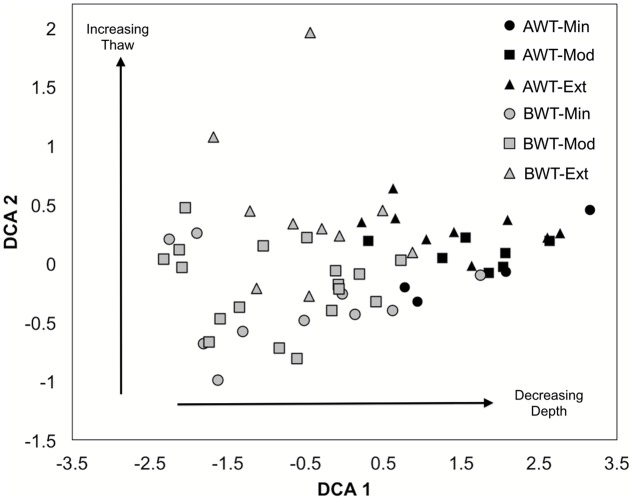
De-trended correspondence analysis ordination of nifH-harboring bacterial communities in all cores related to thaw depth. AWT = above water table, BWT = below water table, Min = minimally thawed site, Mod = moderately thawed site, Ext = extensively thawed site. Arrows indicate trends with depth (AWT versus BWT: PERMANOVA, F = 2.19 P < 0.001) and with increasing/decreasing thaw status (Min, Mod, Ext: PERMANOVA, F = 0.89 P = 0.53). Differences between minimal versus extensively thawed sites were the most highly contrasted (PERMANOVA pairwise comparison, P = 0.06). Multivariate dispersion indices (MVDISP) were 0.88 for BWT and 1.44 for AWT and tested with permutational dispersion (PERMDISP; F = 10.40 P < 0.01).